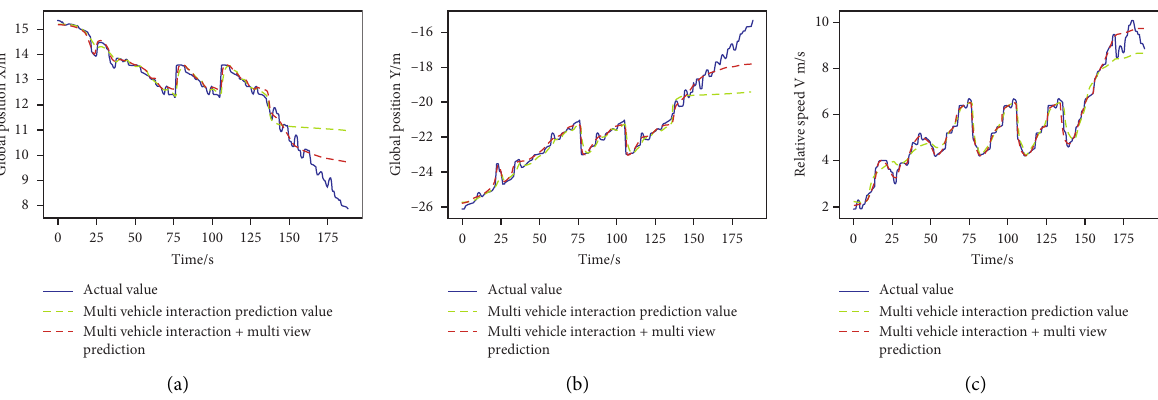
Figure 9: The effect of the Attention-BiLSTM model on the vehicle state prediction in multivehicle interaction scenes based on the multiview point